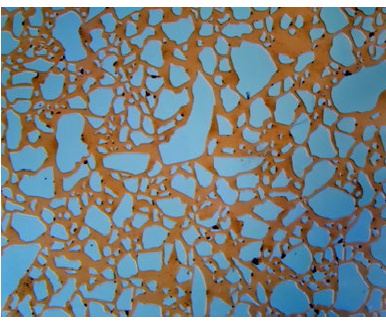
Figure 4. The color of crude oil becomes lighter (Soaking process).